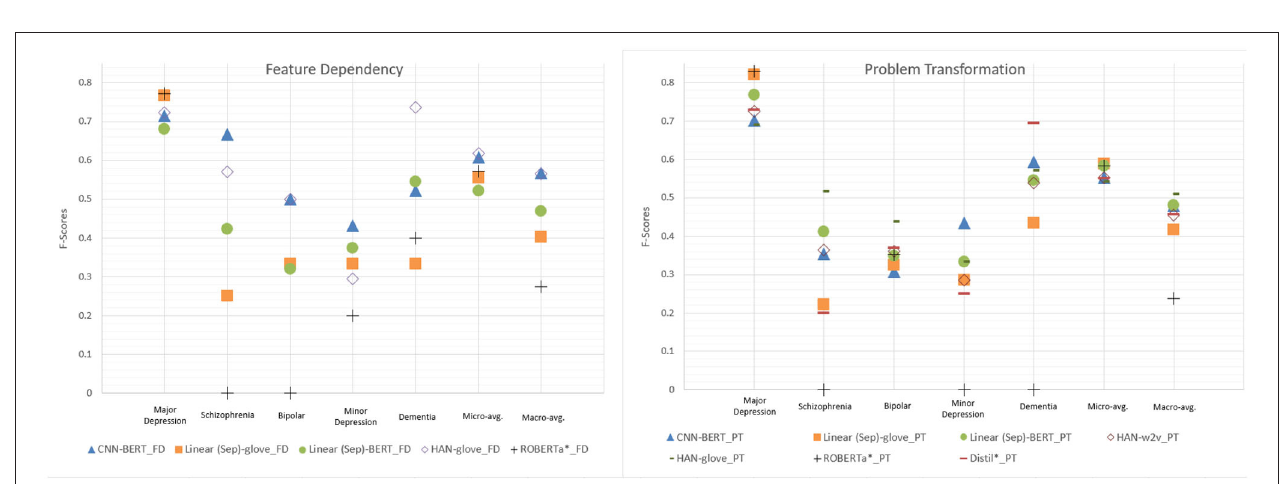
FIGURE 4 | Micro- and macro-average F-scores on the test set of all developed models. “Linear (Mix)” signifies the linear model that considers the BH and PME sections in combination, whereas the “Linear (Sep)” model considers them separately. The figure also includes the performance of BERT* listed in Table 2 as a baseline (BERT-fine tuning) for comparison.